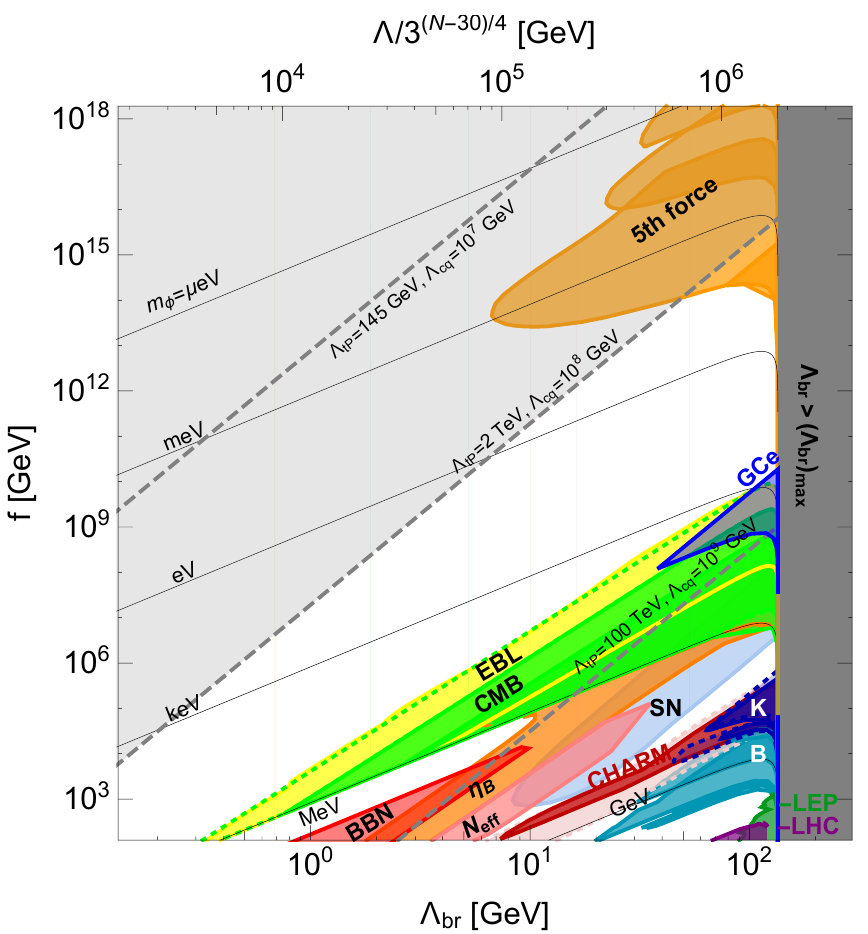
Figure 6 . Summary of laboratory, cosmological, astrophysical and collider bounds on (cid:3) br and f . The upper horizontal axis bounds the cut-o(cid:11) (cid:3) for N = 30 via eq. (4.9). For other (cid:3), the (cid:0) (cid:3) (cid:1) required N is obtained via N = 4 log + 30 where R = (cid:3) = 3 ( N (cid:0) 30) = 4 is the value read o(cid:11) the 3 R upper axis. Laboratory: (cid:12)fth force experiments (light orange). Cosmology and astrophysics: EBL (yellow), CMB (green), globular cluster via coupling to electrons (blue, transparent), BBN (red), entropy injection constrained by (cid:17) B (orange) and by N e(cid:11) (pink), supernova 1987a (light blue). The green dotted lines represent the projection for the sensitivity of PIXIE to CMB distortions. Beam dump experiments: CHARM (dark red) and projections for SHiP (dark red, dotted). For the beam dump projections at NA62 and SeaQuest, see (cid:12)gure 3. Flavour: rare K -meson decays at E949/787, NA48/2, KTEV (dark blue) and projection for NA62 (dark blue, dotted), rare B -meson decays at Belle and LHCb (turquoise). Higgs production and decay at colliders: LEP (green), LHC (purple). The vertical gray band indicates exclusion due to (cid:3) br > (cid:3) max (here (cid:3) max is the upper p br br bound on (cid:3) br arising from the requirement of a non-tachyonic (cid:30) in eq. (3.12) for sin( (cid:30) 0 =f ) = 1 = 2). The dashed, black lines show (from top to bottom) contours of (cid:3) = f 145 GeV ; 2 TeV ; 100 TeV g for (cid:1) (cid:30) = M Pl from the transplanckian (\tp") condition in eq. (1.9). The same contours are obtained for (cid:3) ’ 10 7 GeV ; 10 8 GeV ; 10 9 GeV from the cosmological classical-vs.-quantum (\cq") condition in eq. (1.8). The thin, black lines indicate m (cid:30) from 10 (cid:0) 15 GeV (uppermost) to 1 GeV (lowest) with a spacing factor of 10 3